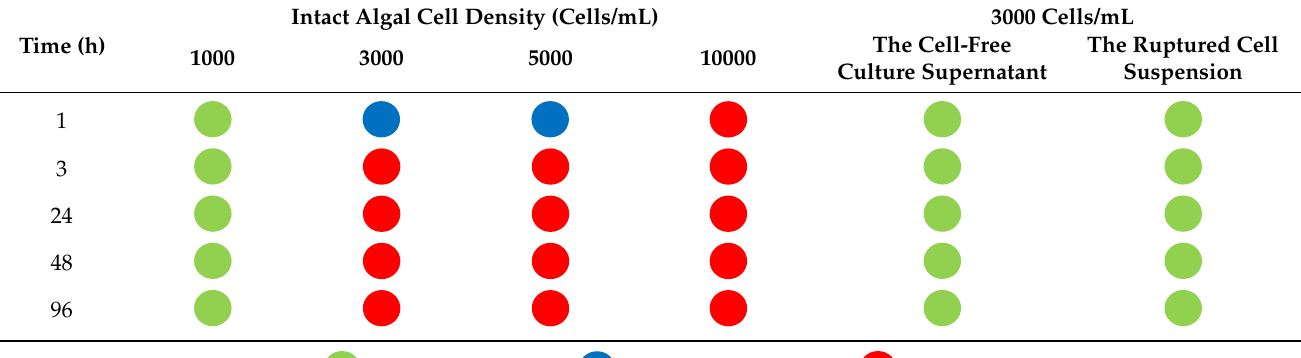
Table 2. The effects of different components of K. mikimotoi on the survival of marine medaka.